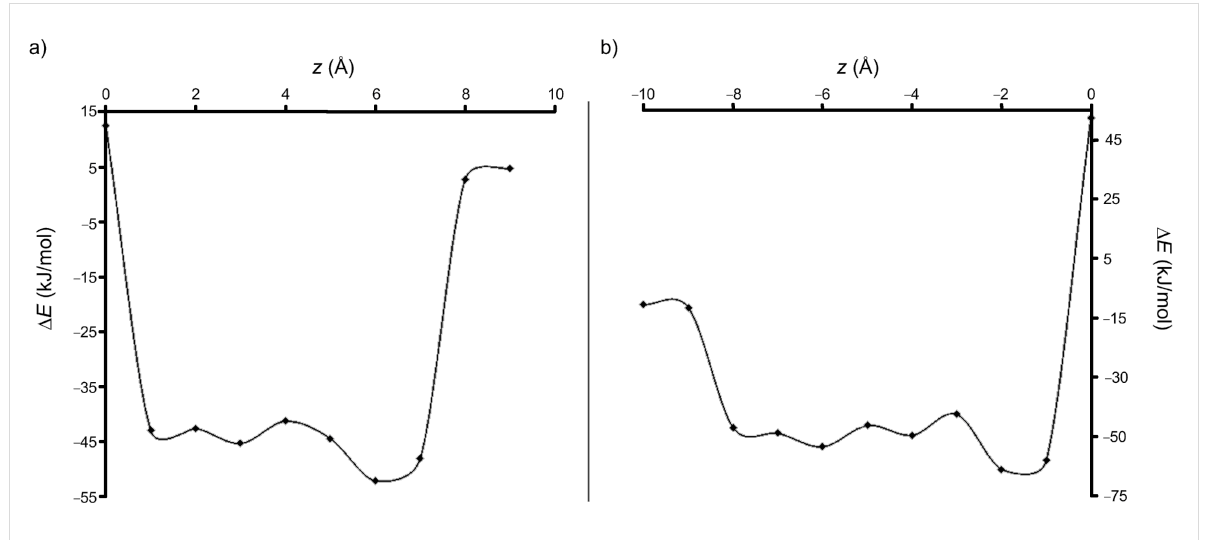
Figure 7: Variation of the stabilization energy during the movement along the z axis, in the case of (a) A and (b) B orientations of PPH + relative to the β -CD cavity (PM3 calculations).